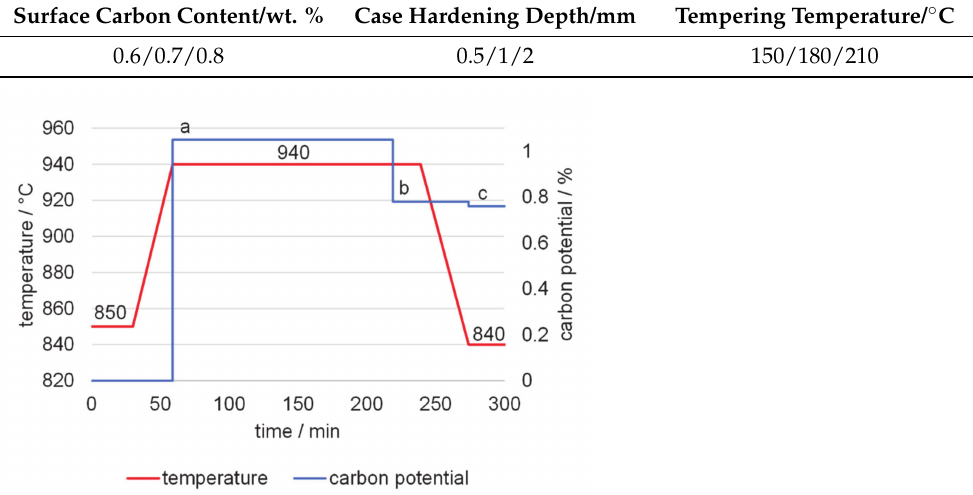
Table 2. Heat treatment variations (target values).